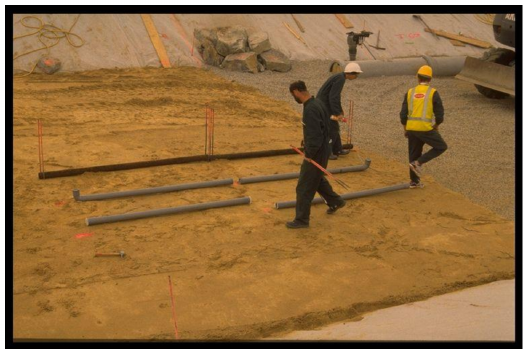
Figure 10. Placement of one of the pipe series in the limestone